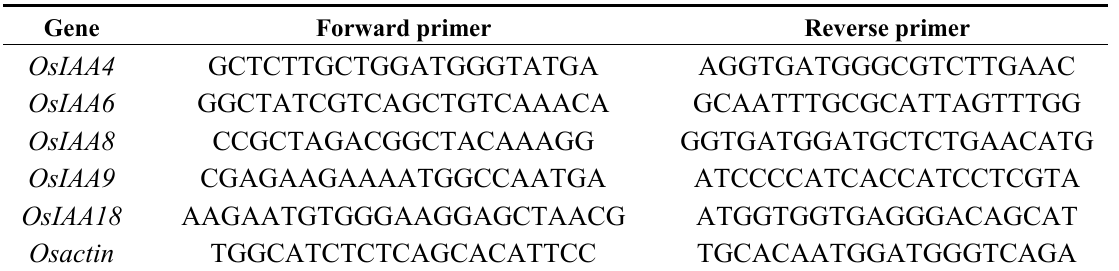
Table 1. Primers used for real-time